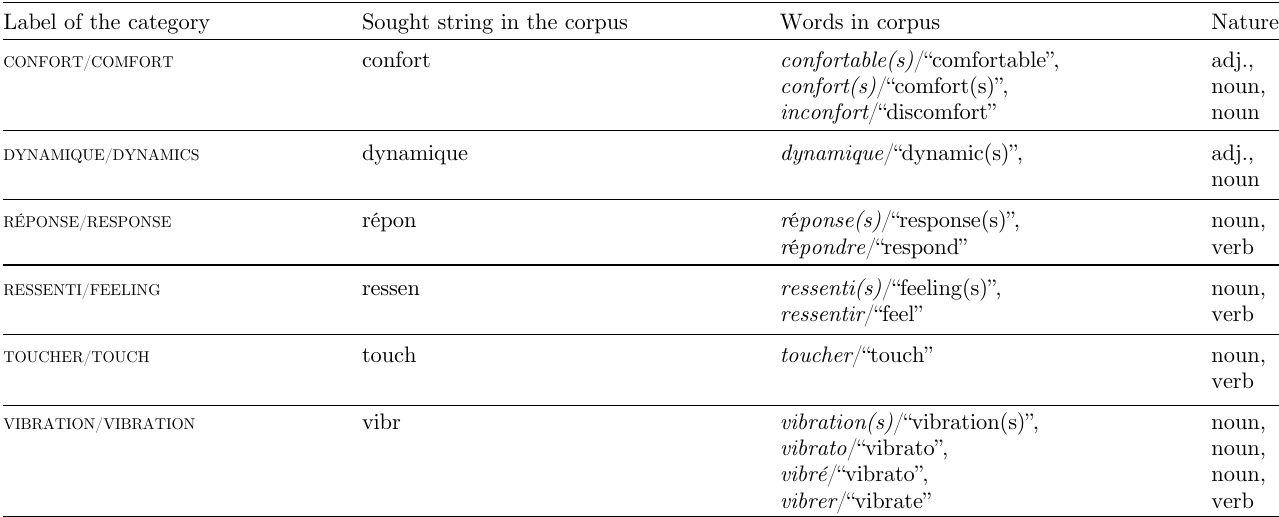
Table 2. Words in the corpus for each category, their speci fi c string characters (used to the semi-automatic research) and nature of words (adjective abbr. adj., noun or